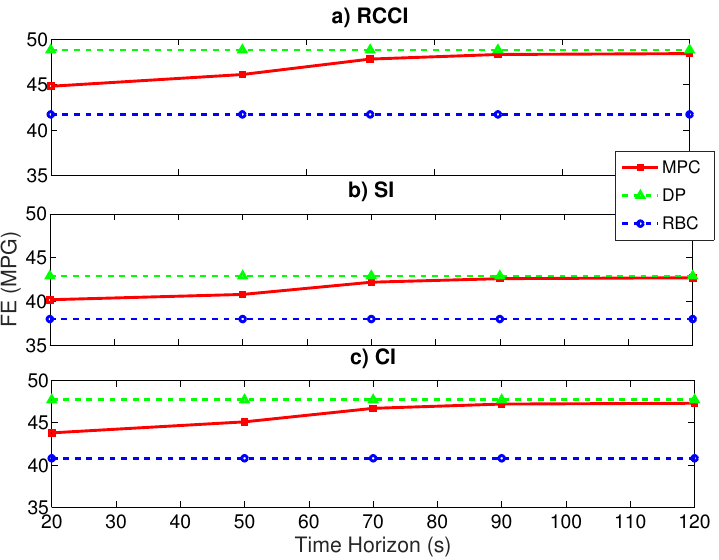
Figure 15. Fuel economy (FE) comparison for ( a ) RCCI; ( b ) SI; and ( c ) CI engines for different